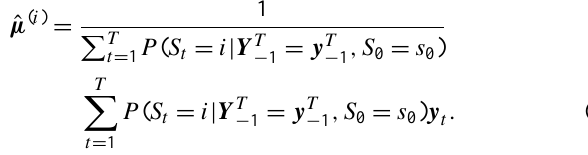
The EM algorithm cycles through two steps: the expec- tation step and the maximization step (Wu, 1983;